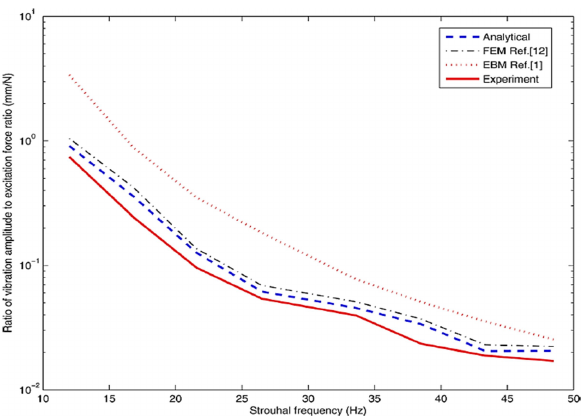
Table 1 and 2 show the: high-performance conduc- tors and their specifications. When galloping, torsional oscillations increase, ice sediment is distributed over the